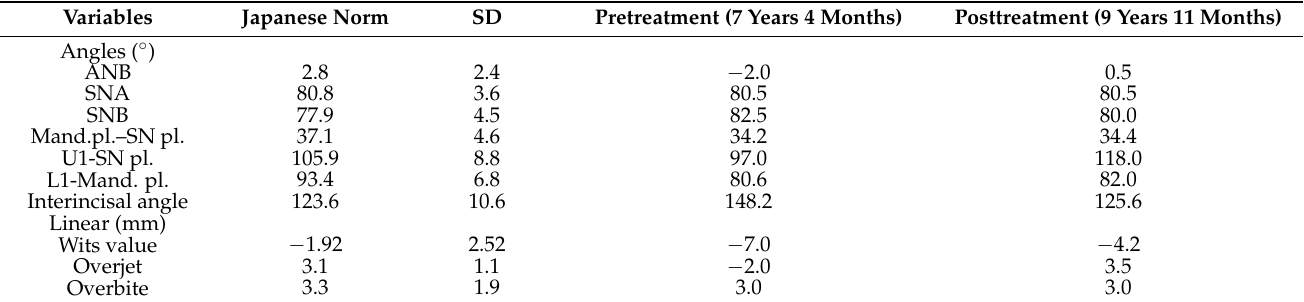
Table 1. Cephalometric summary